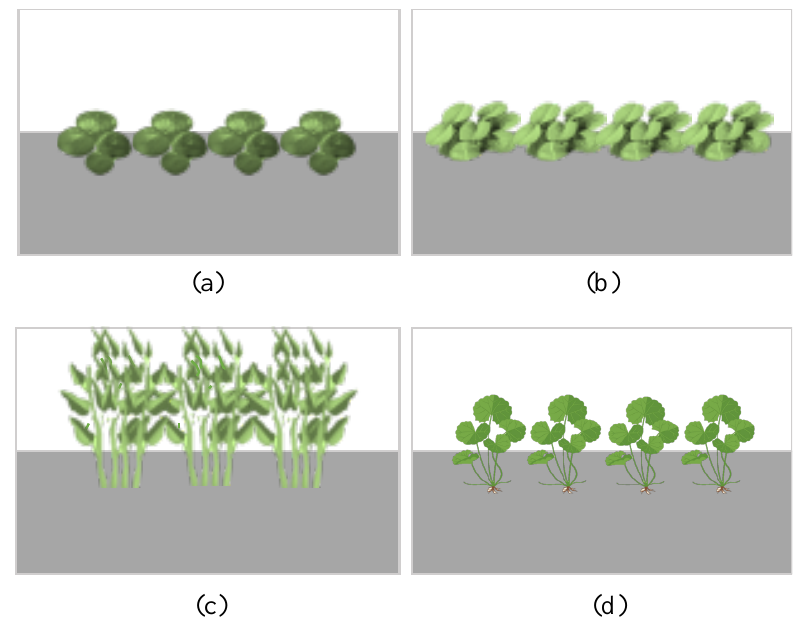
Figure 1. The phytoremediation treatment performed in the laboratory using ( a ) Lemna minor , ( b ) Salvinia minima , ( c ) Ipomea aquatica and ( d ) Centella asiatica .